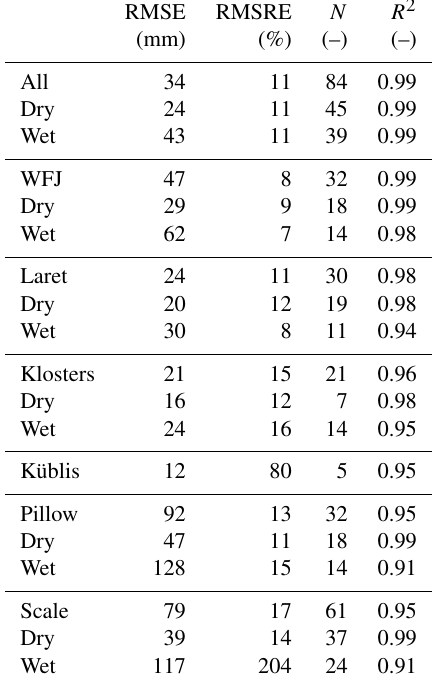
Table 2. Root mean square error (RMSE), root mean square rela- tive error (RMSRE), number of data points N and linear regression parameters (slope, intercept and R 2 ) for GNSS-derived SWE com- pared to the manual measurements for the single stations and all data (for both winter seasons). For the snow pillow, the data from Weissfluhjoch were used. For the snow scale, the analysis includes data from Weissfluhjoch and